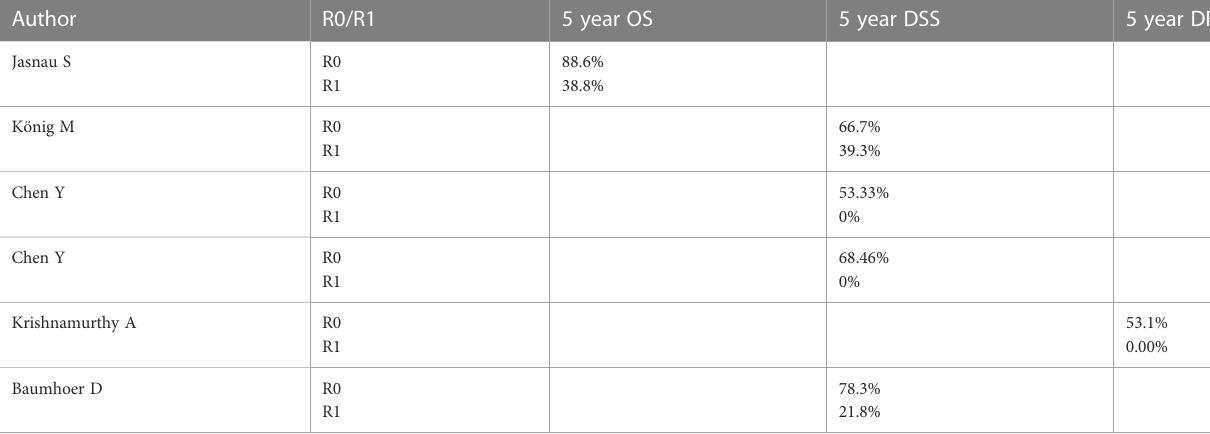
TABLE 3 Survival rate related to resection margins in COS patients.